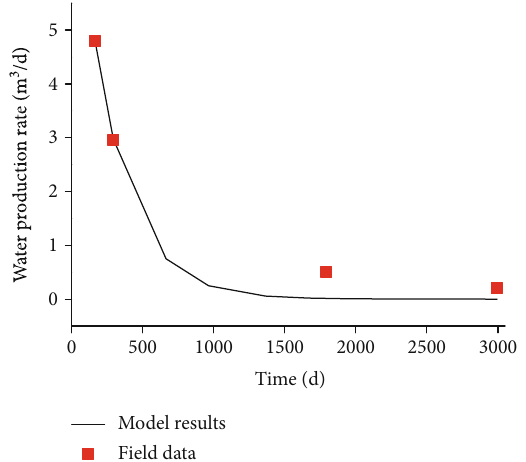
Figure 3: Variation of water production rate with time.